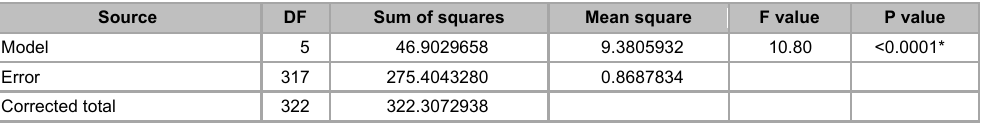
General Linear Model result for the factor “Objectives of the small business policy” as dependent variable Source DF Sum of squares Mean square F value P value Model